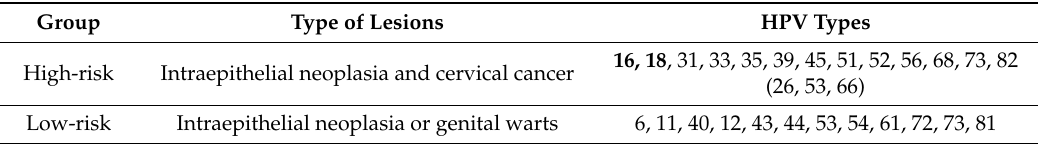
Table 1. Human papillomavirus (HPV) types and associated lesions. Represented in bold are the most frequent high-risk HPV. HPV types that are not yet fully established as high-risk are represented between brackets.